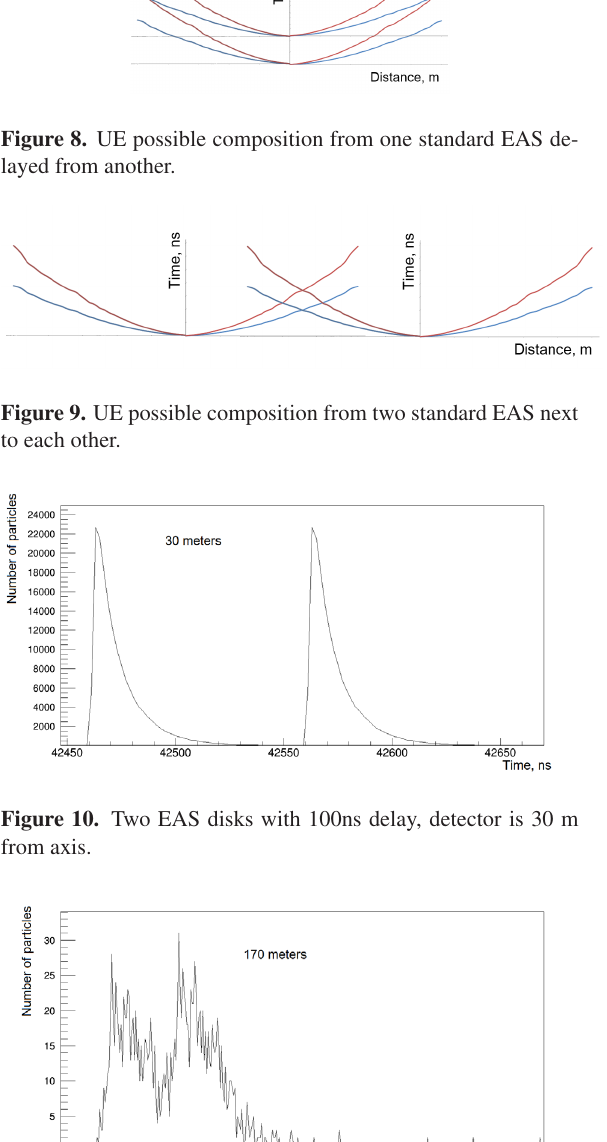
Figure 6. Unusual event from HT data.